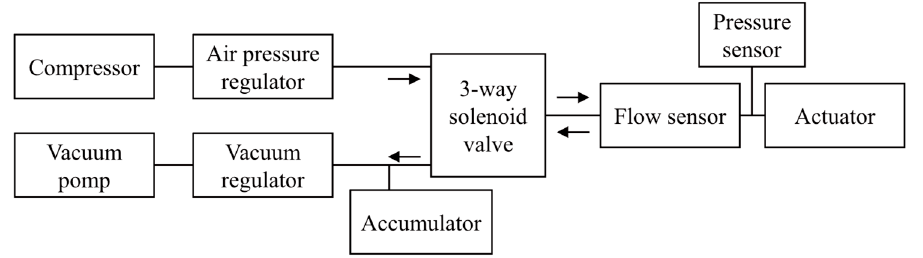
Figure 18. System configuration diagram of the repeated durability test.